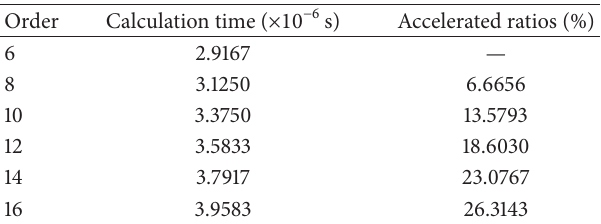
Table 4: Comparison of the calculation time of control force under different orders Order Calculation time ( ×10 −6 s) Accelerated ratios